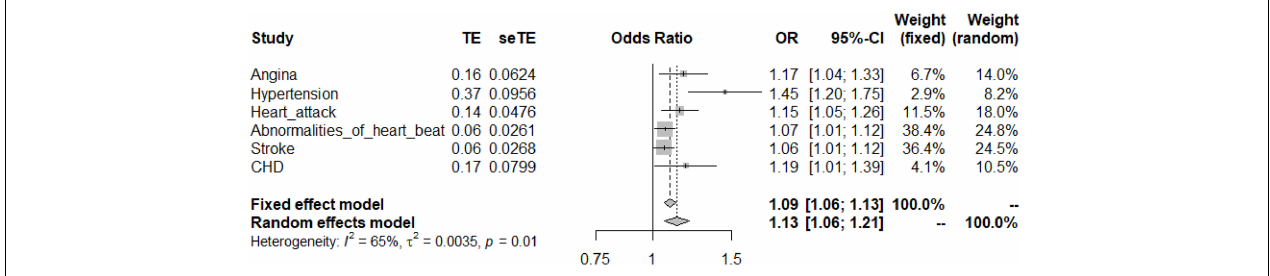
FIGURE 1 | Mendelian randomization (MR) analysis between rheumatoid arthritis (RA) and six cardiovascular diseases. TE, treatment effects ( β ); se TE, standard error of treatment effect